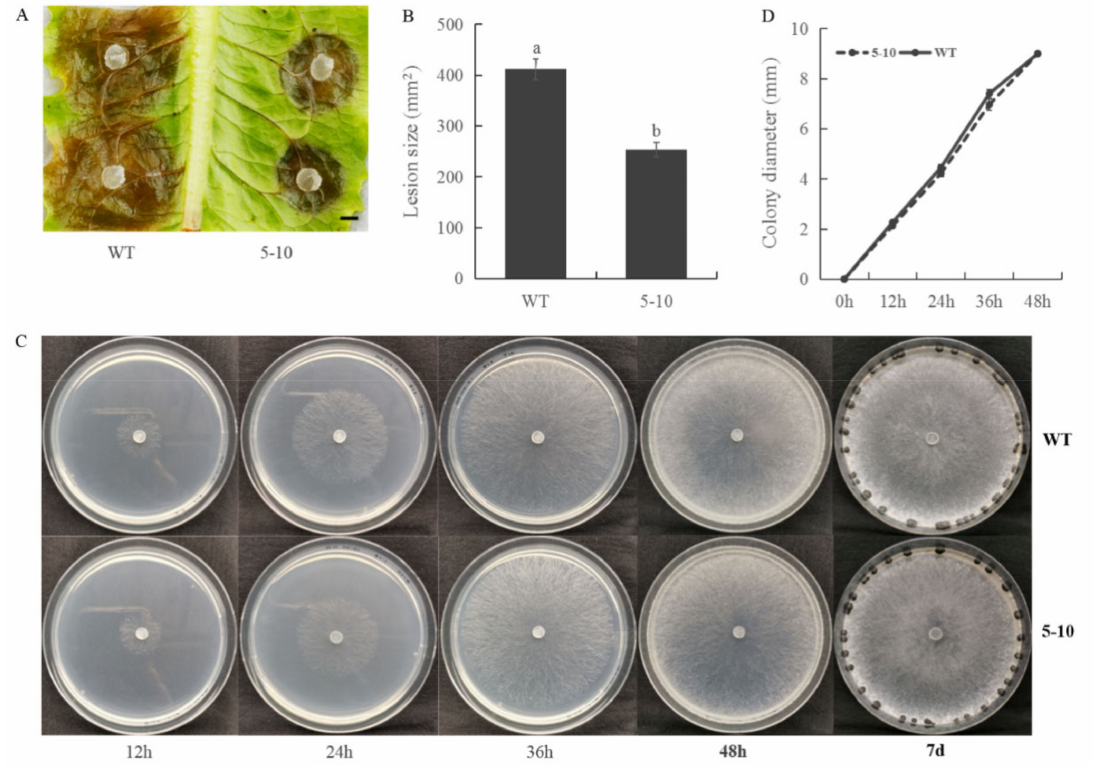
Figure 1. Virulence on lettuce leaves and mycelial growth phenotypes of the 5–10 mutant. ( A ) Necrotic lesions caused by S. sclerotiorum infection on lettuce leaves. Bar = 5 mm. Data were recorded at 36 h post-inoculation (hpi). WT: wild-type. ( B ) Quantification of lesion size of WT and 5–10 on